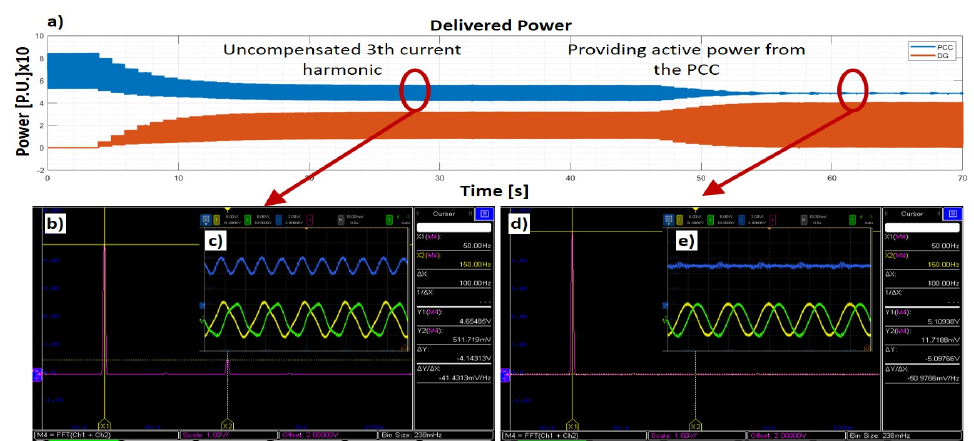
Figure 5. Power and currents delivered by the PCC and the DG for case 1: ( a ) PCC and DG power-Time domain. ( b ) Frequency spectrum and ( c ) time domain PCC signals when 3th harmonic was not